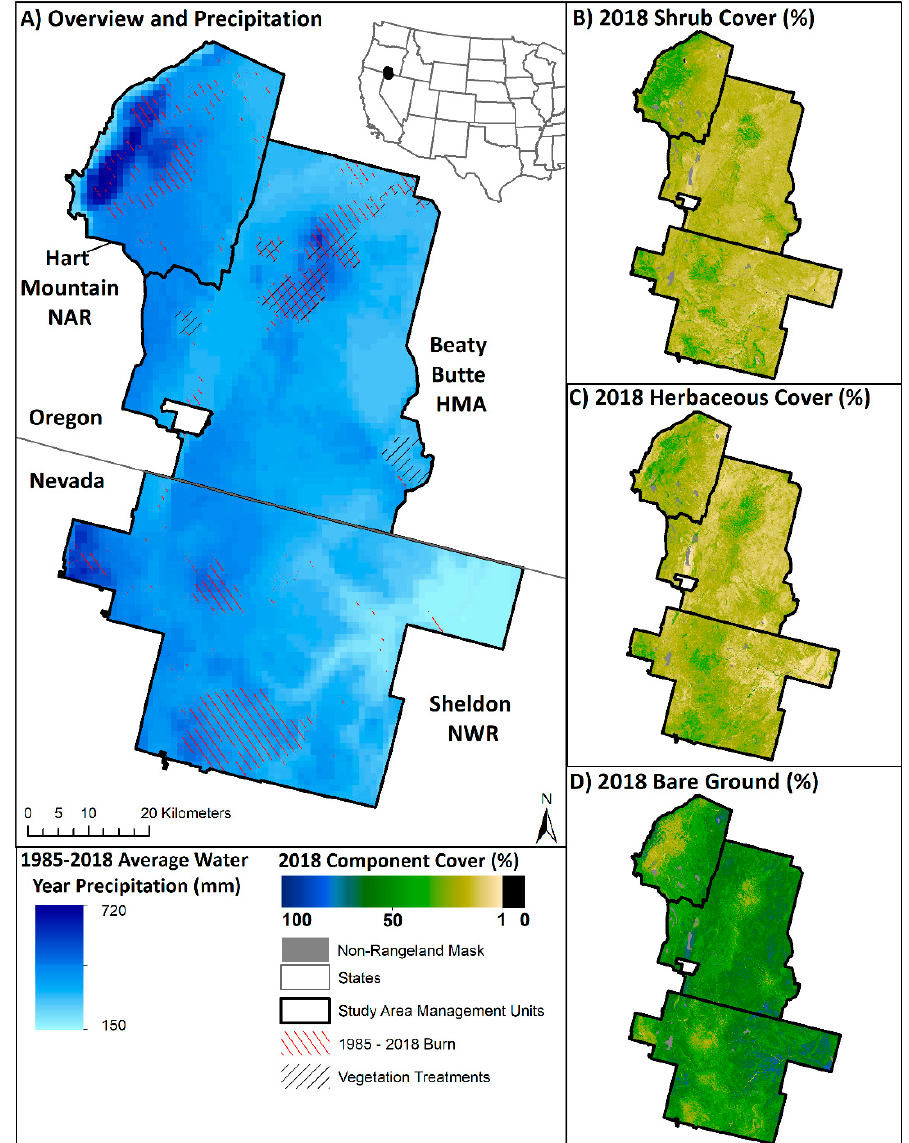
Figure 1. Study area overview. ( A ) Management units and 1985-2018 average water year (October-September) precipitation generated from Daymet data. Also depicted are 1985-2018 burns and Bureau of Land Management vegetation treatments. Inset panel shows location of study area within the western U.S. Fractional cover of ( B ) shrub, ( C ) herbaceous, and ( D ) bare ground are shown for 2018.